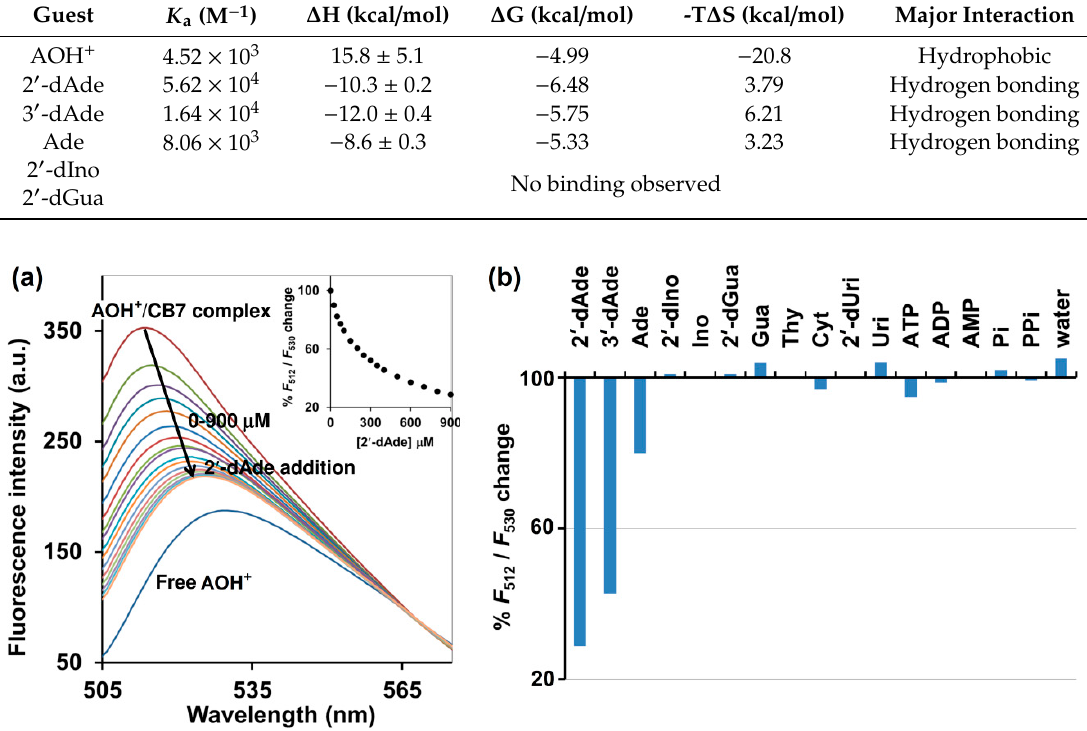
Table 1. Thermodynamic parameters of complex formation between CB7 and guests (AOH + and different nucleosides) assessed by isothermal titration calorimeter in 10 mM ammonium acetate buffer (pH 4.0).